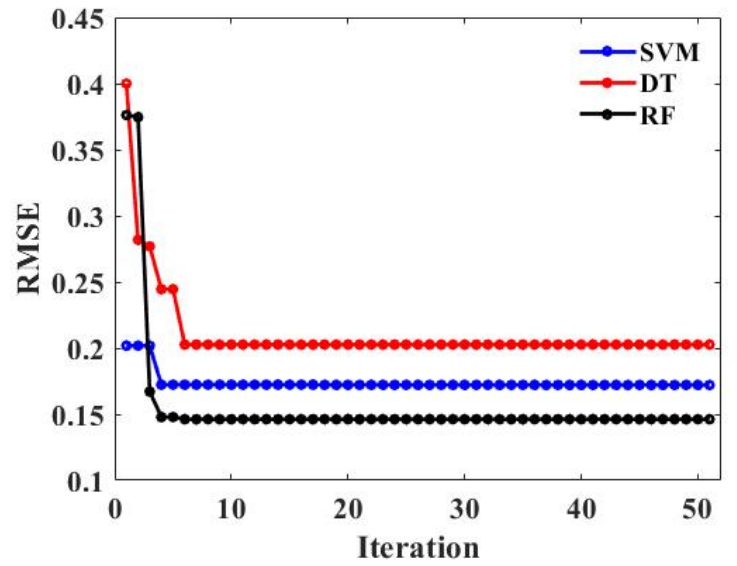
Figure 4. The relationship between the number of iterations of the models and RMSE values.